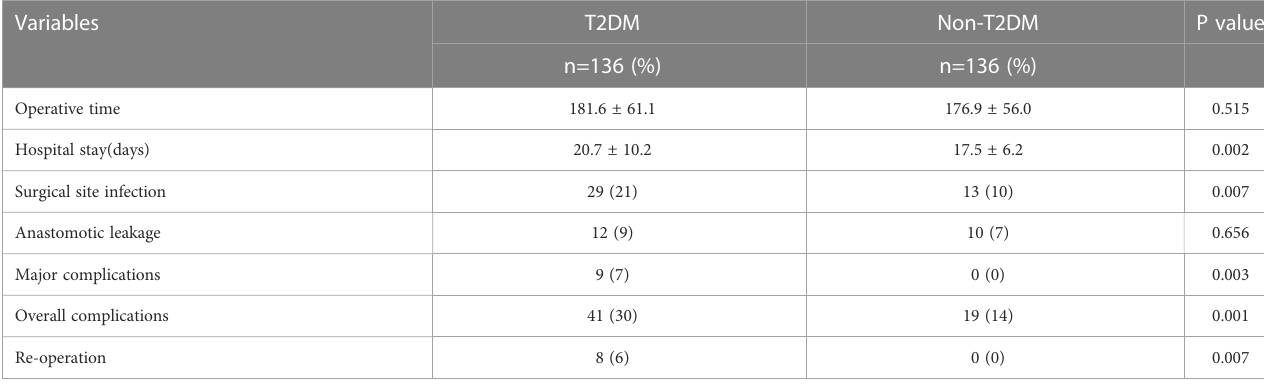
TABLE 2 The short-term outcomes between the two groups.